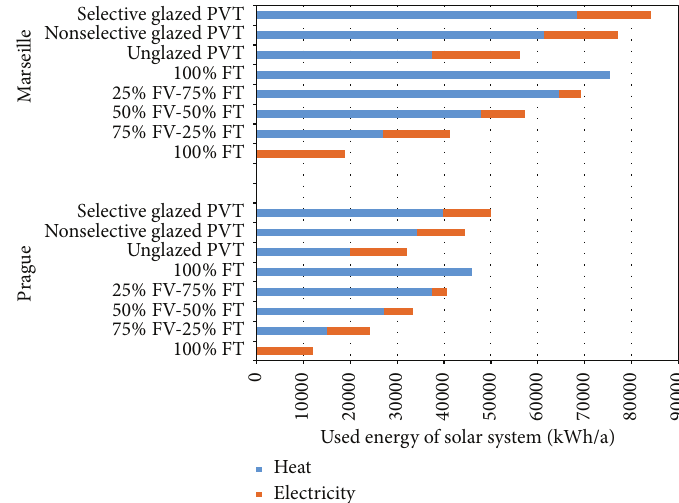
Figure 6: Comparison of energy gains for different PVT collector designs and conventional combination.